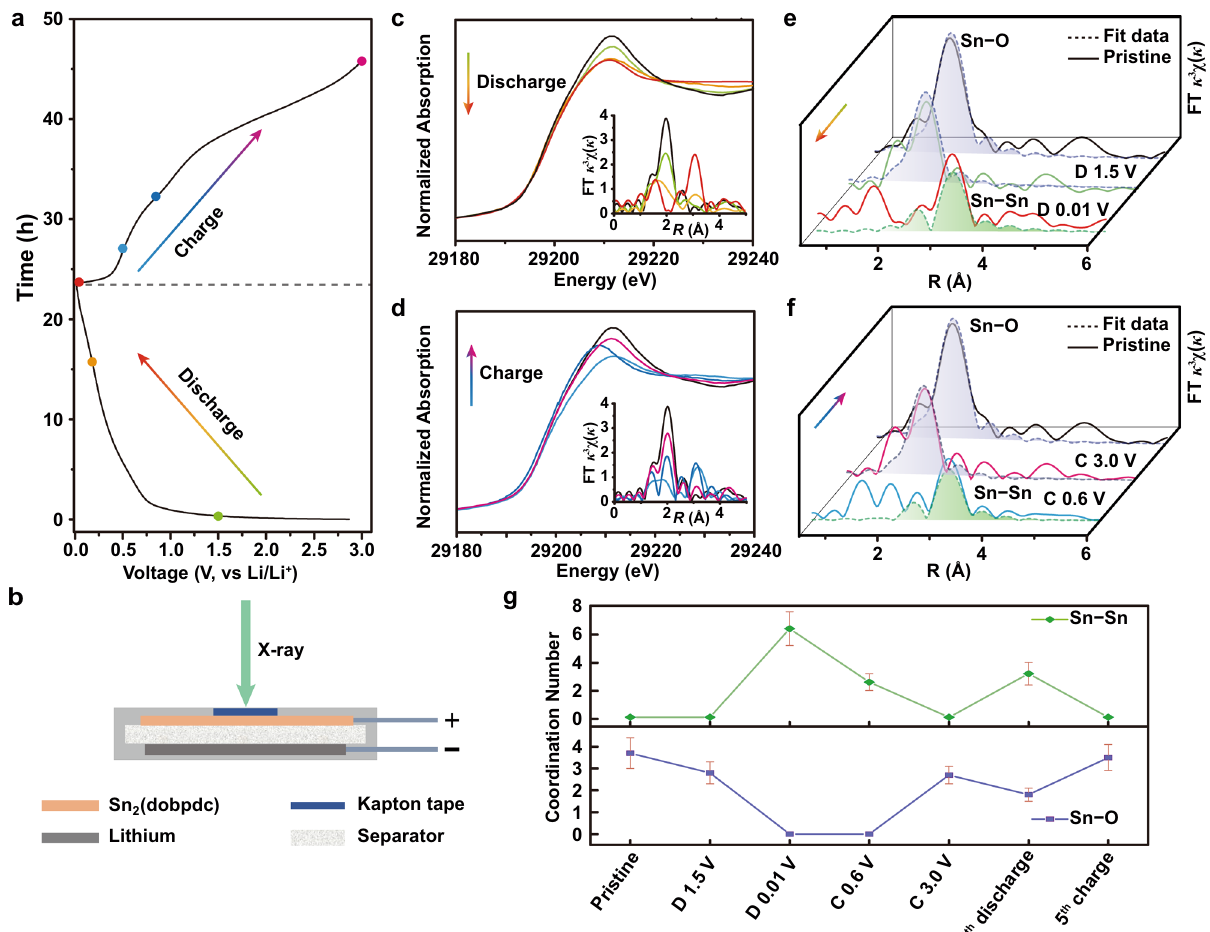
Fig. 5 Structural characterization by quasi-in situ XAFS spectroscopy during a lithiation-delithiation cycle of Sn 2 (dobpdc). a Load curve during the second discharge – charge process at 50 mA g − 1 with marked states for quasi-in situ XAFS tests. b Schematic cross-section of a coin-type battery for the quasi-in situ XAFS test. c , d Sn K-edge XANES during the discharge – charge process. The insets display the corresponding Sn K-edge k 3 -weighted FT-EXAFS spectra. e , f Sn K-edge k 3 -weighted FT-EXAFS spectra fi tting in R space for selected states during the discharge – charge process. The black lines in c - f correspond to the XAFS spectra of the pristine electrode. g CNs of near neighbors around Sn atoms at different states in the quasi-in situ